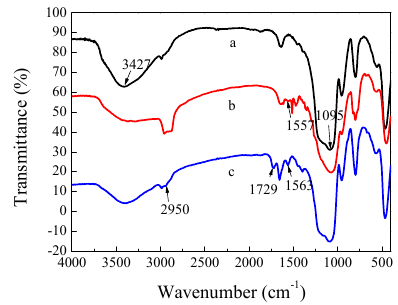
Figure 4. FT-IR of ( a ) CdTe/SiO 2 ; ( b ) CdTe/SiO 2 -NH 2 ; ( c ) CdTe/SiO 2 -COOH particles.